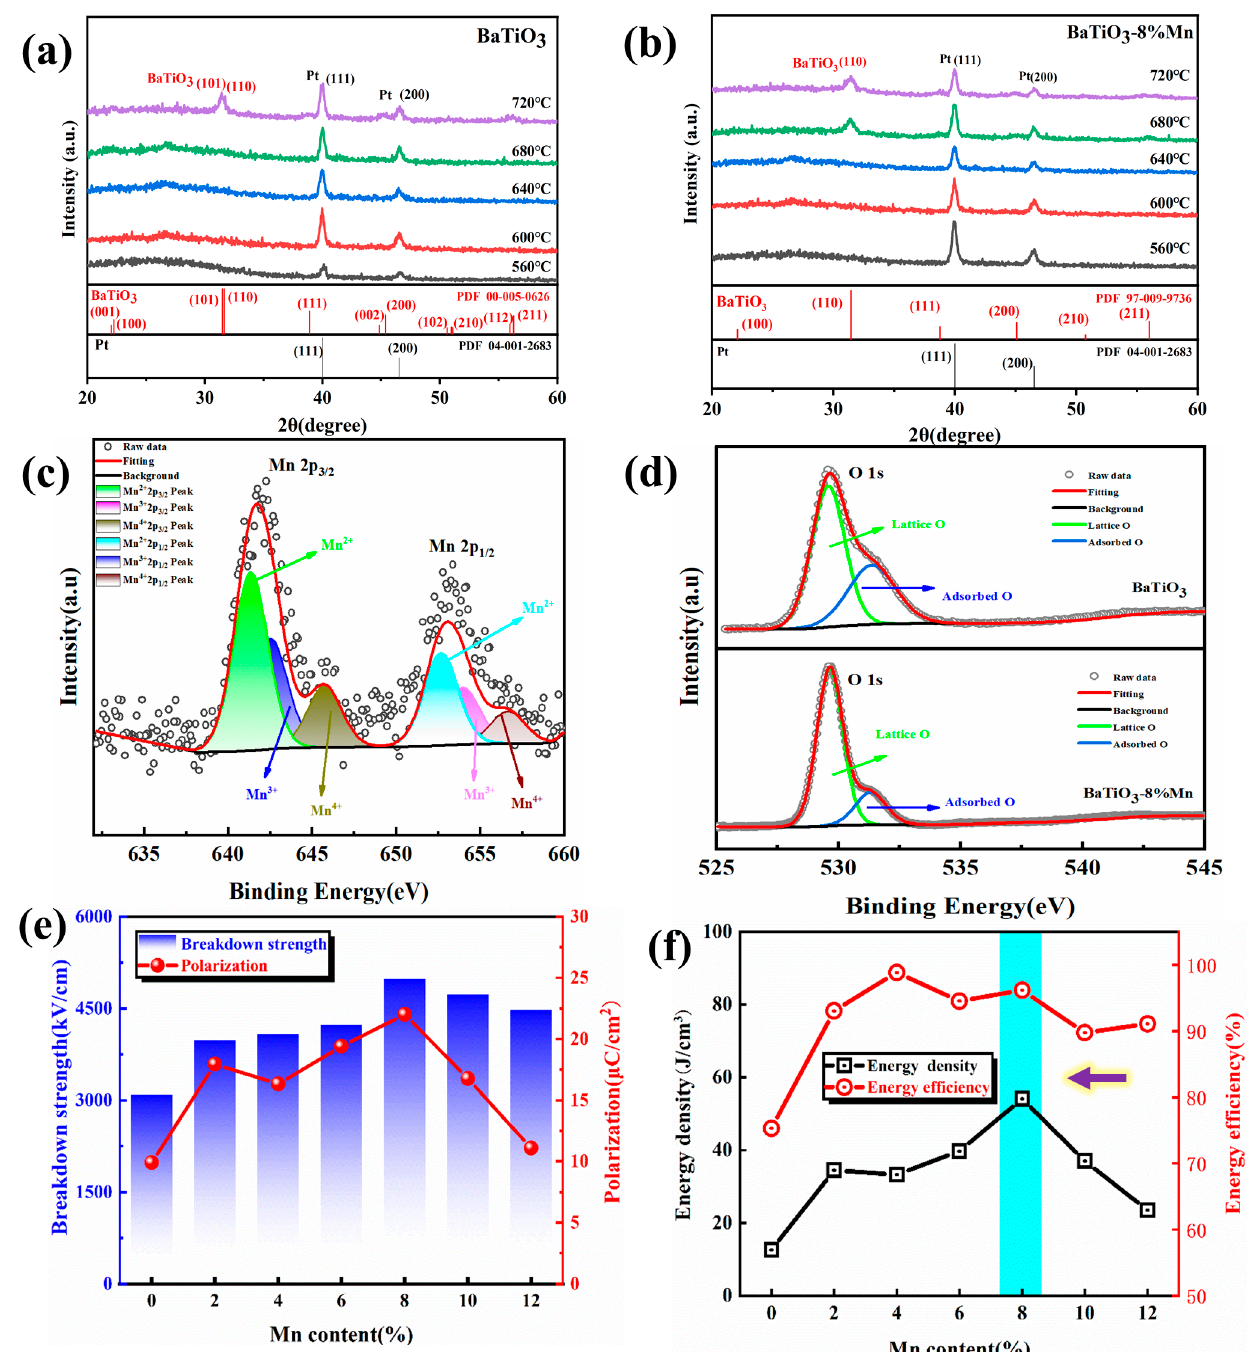
Figure 1. GIXRD spectra at different annealing temperatures: ( a ) BT films; ( b ) BT-8%Mn films; ( c ) Mn 2p XPS spectrum in BT-8% Mn films; ( d ) XPS spectrum of O 1s in BT and BT-8%Mn films; ( e ) polarization and breakdown strength of BT-x %Mn films; ( f ) energy storage performance of BT-x %Mn films.